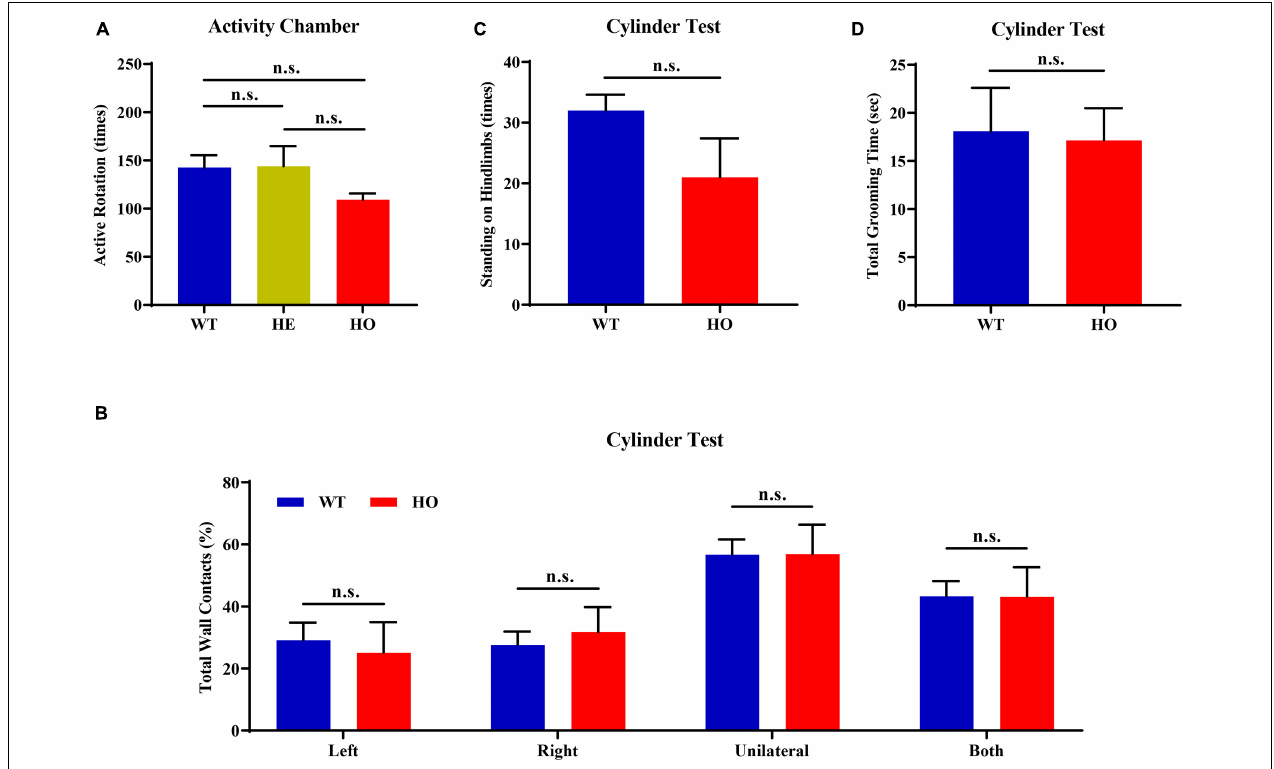
FIGURE 4 | Normal motor coordination abilities revealed by the spontaneous activity chamber and cylinder test in Slc20a2 -deficient mice. (A) Total active rotation number in the last 5 min in the activity chamber. (B–D) Cylinder test for locomotor asymmetry: (B) total number of wall contacts (proportion) using upper limbs, (C) standing times on hindlimbs, and (D) total grooming time. WT, wild Slc20a2 genotype; HE and HO, heterozygous and homozygous Slc20a2 gene trapping/knockout; n.s., not statistically